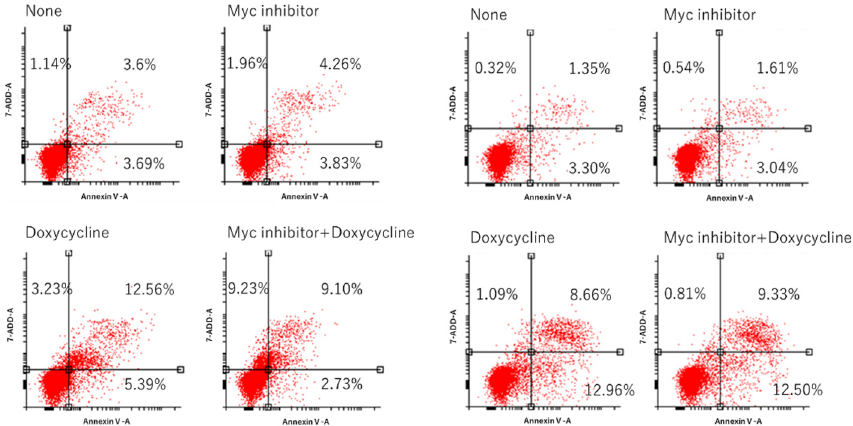
Figure 10. The Tet-on p53 myeloma cell line proliferation and apoptosis after treatment with Myc inhibitor 10058-F4 and doxycycline. ( A ) KMS26 and ( B ) OPM2 were treated for 72 h with 20 µM of Myc inhibitor and/or 1 µg/mL doxycycline. Experiments of proliferation were performed in triplicate. Error bars show the standard deviation (SD) within triplicated experiments. Blue, no treatment; orange, with 20 µM Myc inhibitor; yellow, with 1 µg/mL doxycycline; light blue, with co-treatment of Myc inhibitor and doxycycline. Apoptosis was measured once after treatment for 72 h. In dot plot, left top, no treatment; right top, with 20 µM of Myc inhibitor; left bottom, with 1 µg/mL doxycycline; right bottom, with co-treatment of Myc inhibitor and doxycycline.